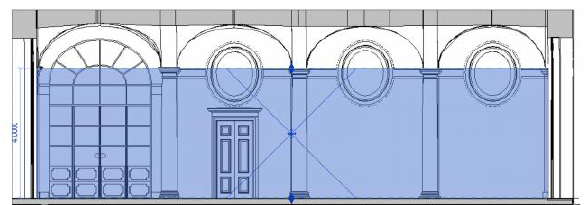
Figure 15. Trying to define the environment “ Hall of columns ”